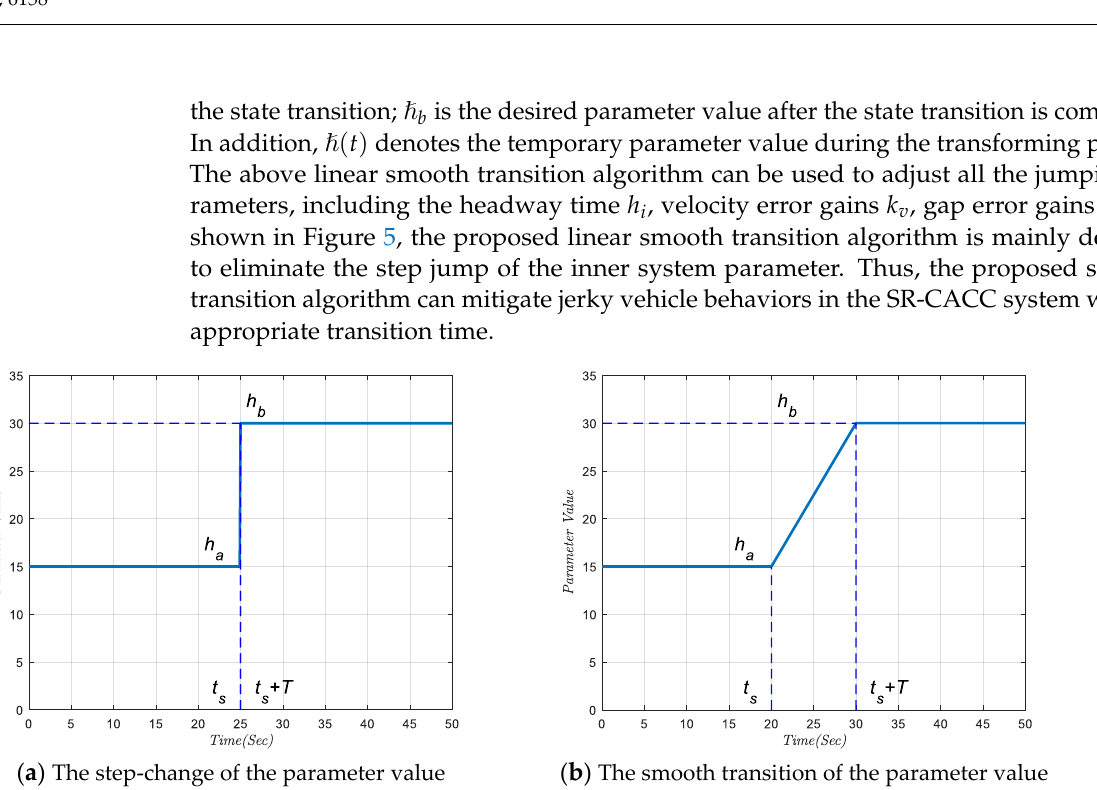
Figure 5. The working mechanism of smooth transition algorithm.